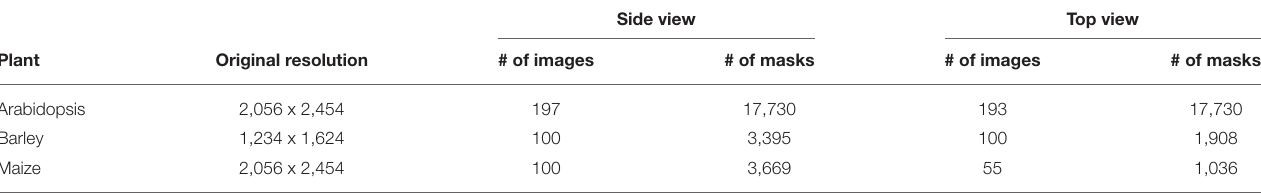
Side view Top view